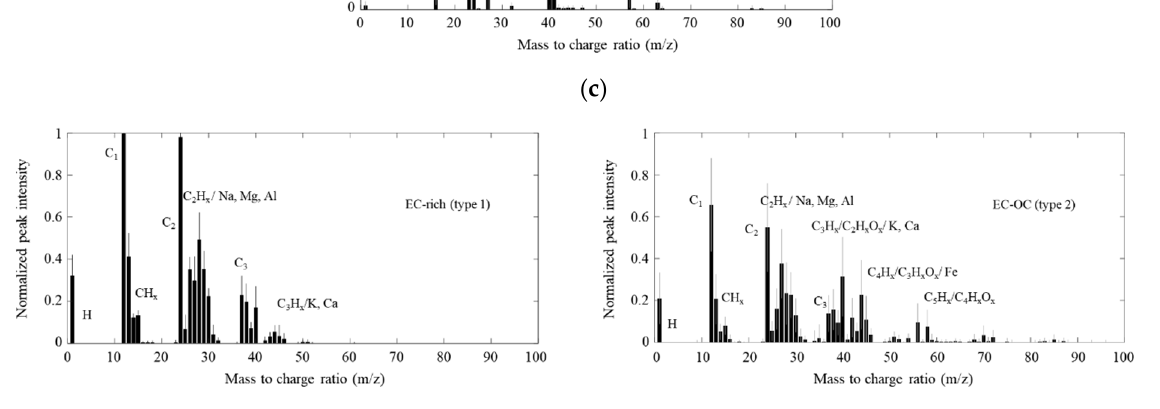
Figure 6. Single-particle mass spectra of ( a ) diesel engine exhaust particles, ( b ) rice straw burning particles, ( c ) coal burning particles, and ( d ) pork burning particles classified by the K-means algorithm.